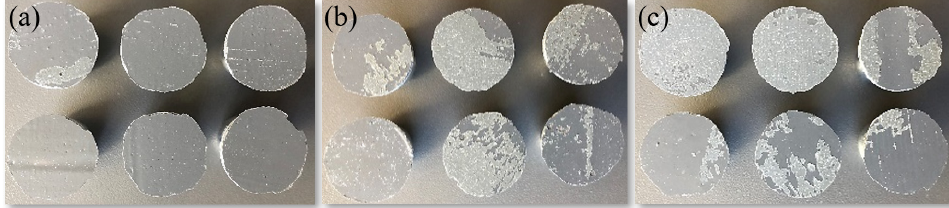
Figure 6. Failure patterns of coating materials ( a ) RL; ( b ) RL_G5; ( c )